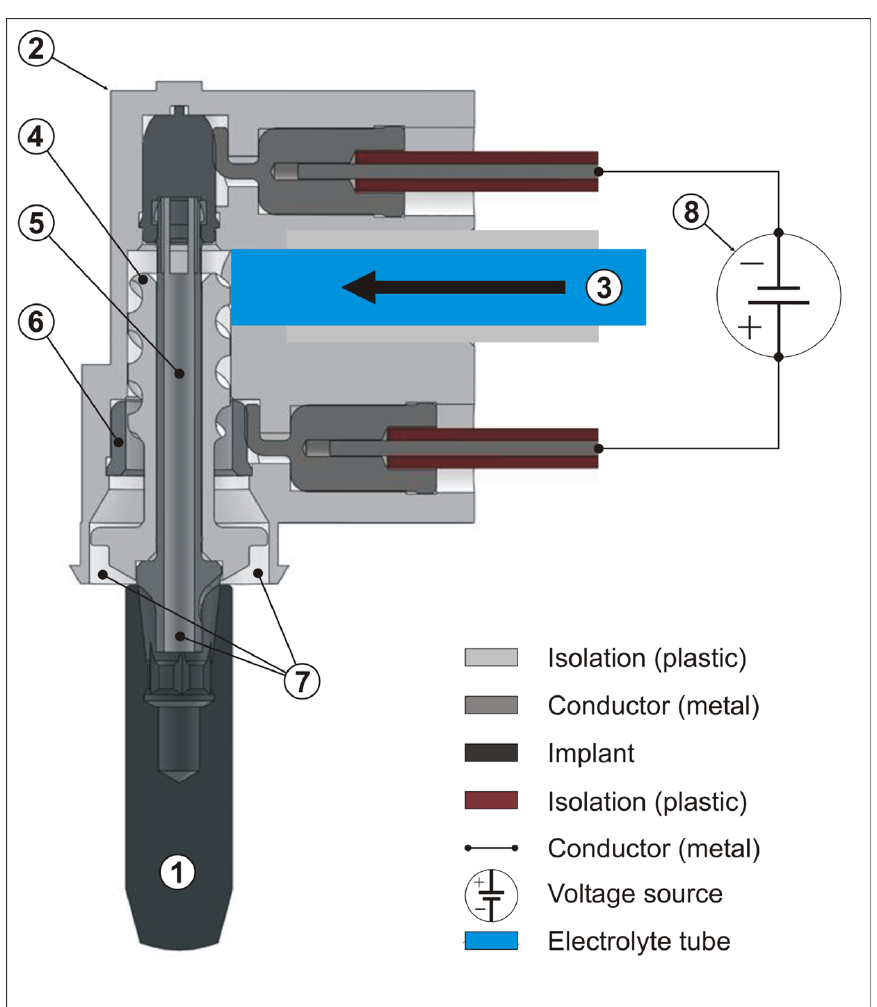
Figure 1. Composition of the spray-head. (1) Implant (loaded as a cathode); (2) spray head; (3) tube for electrolyte; (4) spiral-like threaded isolator; (5) connector (loaded as a cathode); (6) anode; (7) shower head (exit of electrolyte); (8) control unit and voltage source. Application of Figure 1: The spray-head (2) has to be pressed on containment of the implant (1) manually. The electrolyte will be pumped through the tube (3) and passes the spiral of the treaded isolator (4), reaches the anode (6), and will be sprayed by the shower head (7) onto the exposed implant surface. A second pathway branching o ff from the threaded isolator to the implant connector (5) pumps electrolyte in the implant containment (1). The positive current path derives from the voltage source (8), passes metallic conductors to the anode. The negative current path derives from the voltage source (8), passes metallic conductors to the connector (5), to the implant (1), which acts in the electrolytic process as the